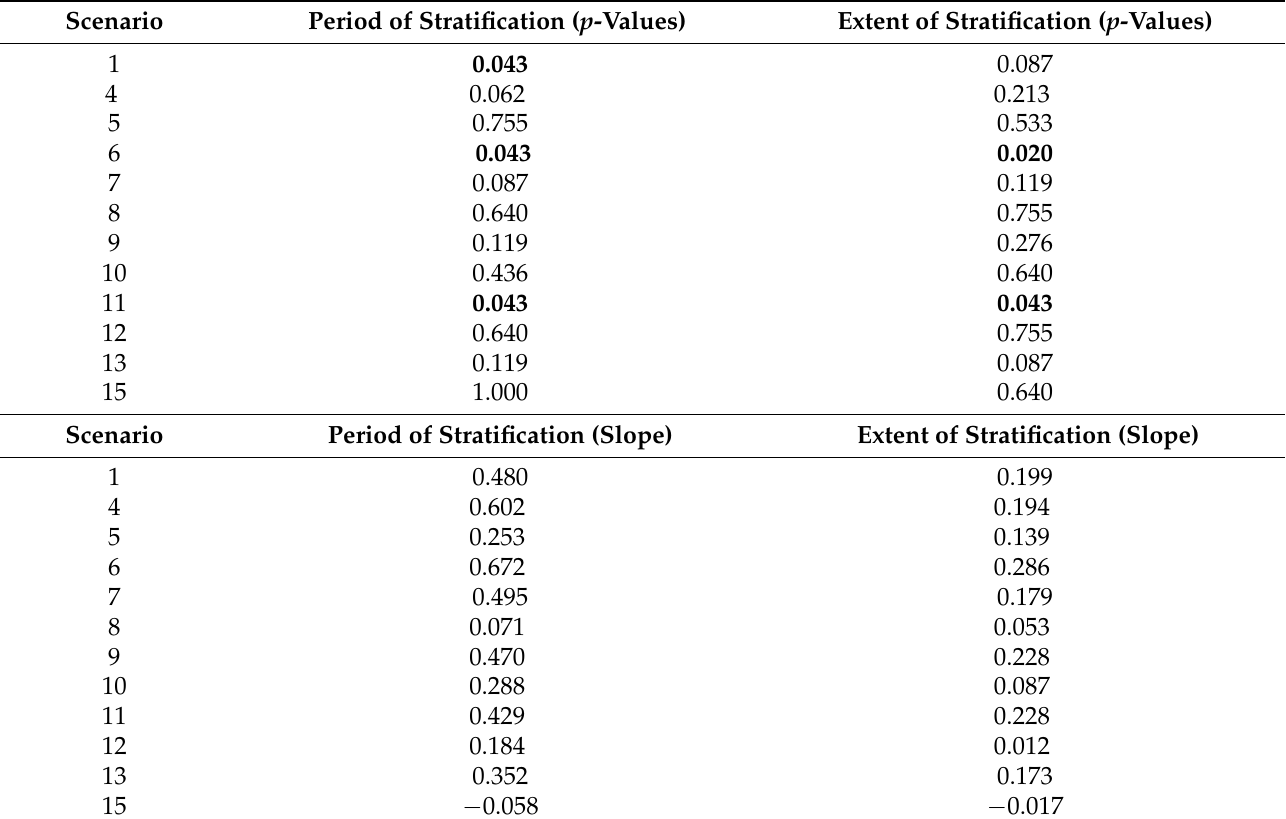
Table 3. p -values (calculated with the Mann-Kendall test) and slope of fitted linear trends for mean water temperature, S and mixing events from the 12 different climate scenarios across the range of years for which the model was run. Bold text shows statistically significant p -values of below 0.05, indicating a relationship between the modelled parameters and time not likely attributed to